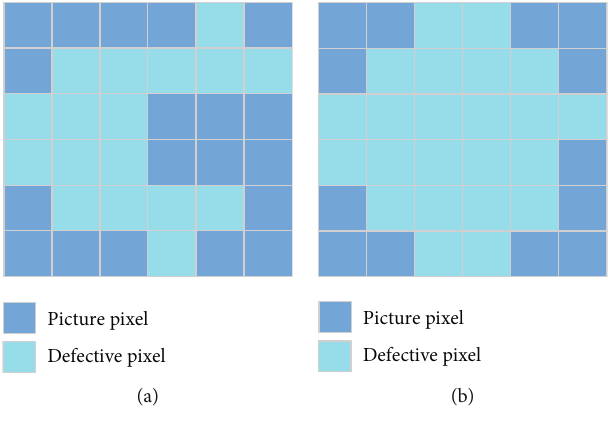
Figure 5: Area extraction of defect